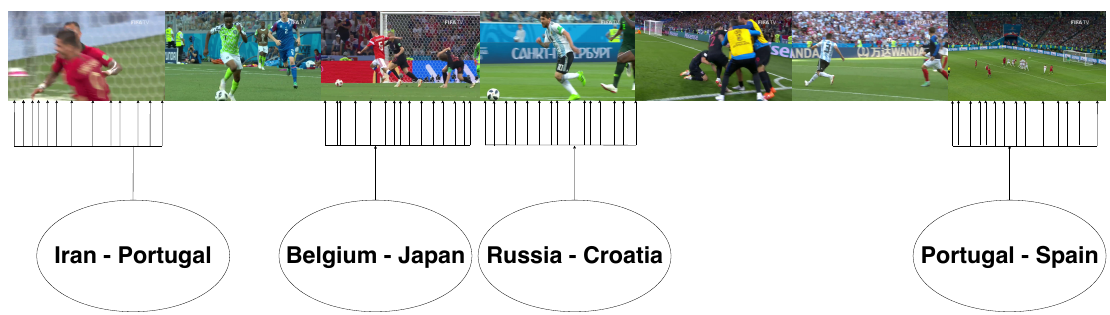
Figure 5. Schema of the process used to convert videos into